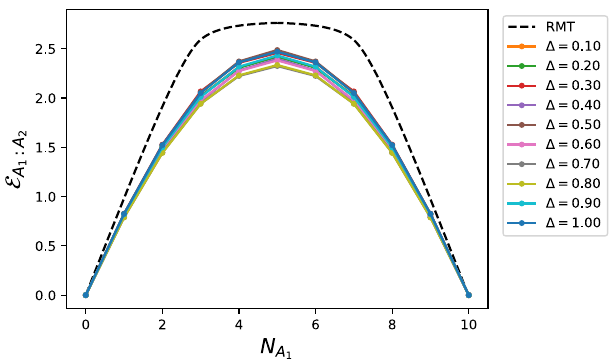
FIG. 10. Logarithmic negativity of two adjacent intervals of and N A in a highly excited state of a XXZ spin length N A 1 2 chain Eq. (E2) for various values of ZZ coupling (cid:18) . Here, + N = 10 and N = 4. The deviation from the random N A A 2 B 1 matrix theory (dashed line) is consistent with the fact that this model is